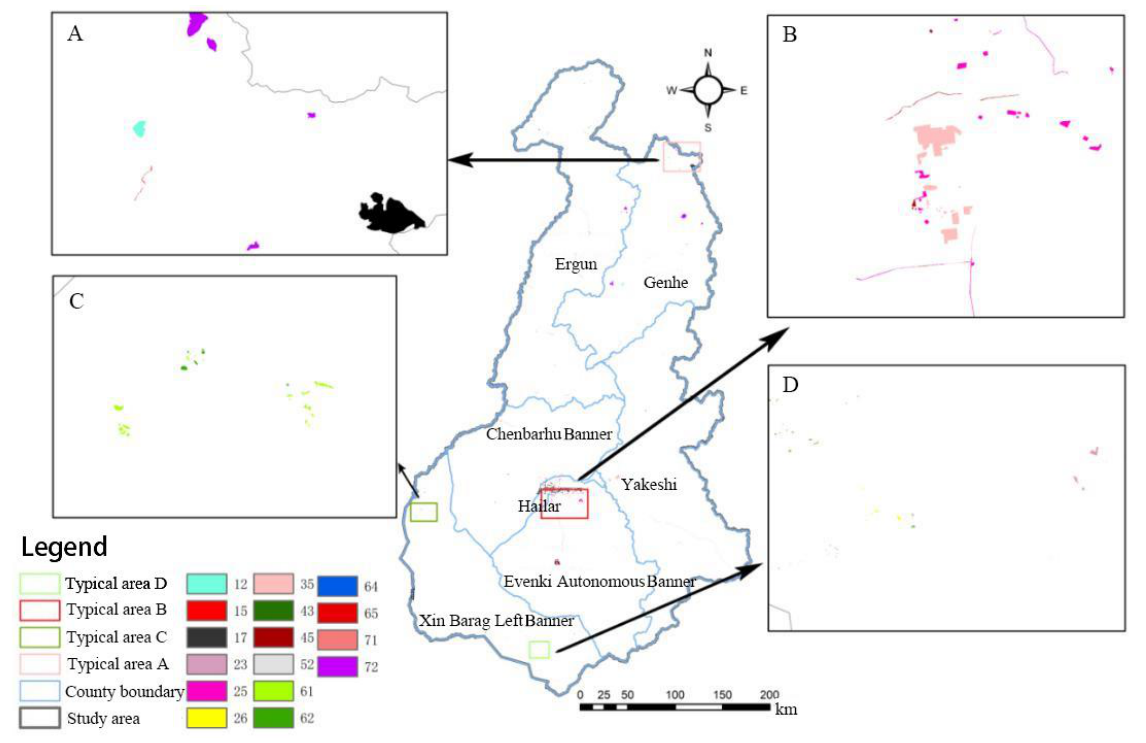
Figure 8. Land cover conversion map from 2010 to 2018: 1 represents forest; 2 represents grassland; 3 represents farmland; 4 represents wetland; 5 represents urban land; 6 represents desert; 7 represents burned land; 12 represents the change from forest to grassland; and 15 represents the change from forest to urban land.